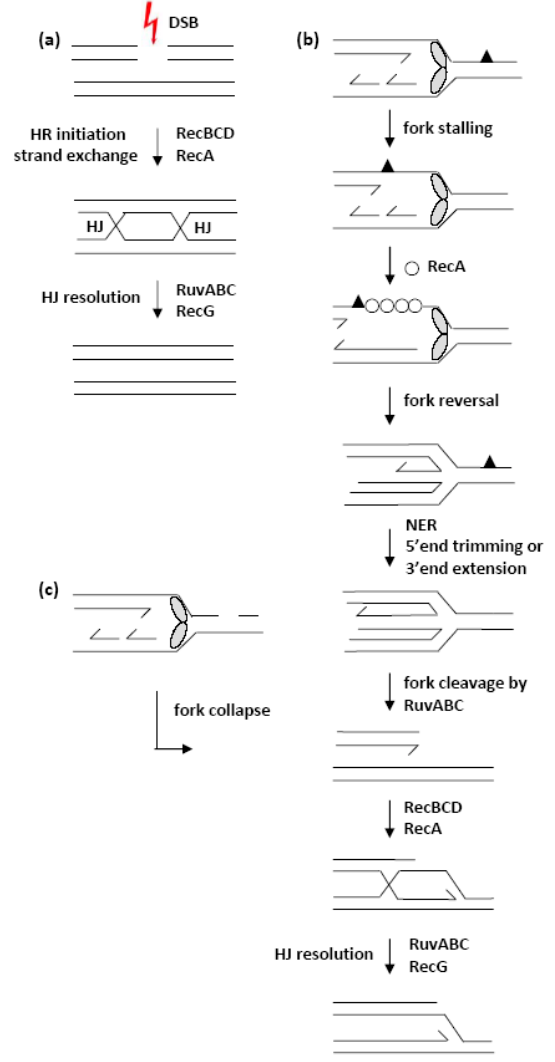
Figure 12. Models depicting the possible sources of DSBs and the corresponding repair pathways following the three different DNA-damaging treatments used in this work. ( a ) Classical DSB induced either by I- Sce I endonuclease or γ -irradiation has two dsDNA ends that are repaired by the RecBCD pathway of homologous recombination (HR). ( b ) In UV-irradiated cells, most DSBs are caused by the breakage of stalled replication forks. The drawing shows the progression of the replication fork on a DNA template damaged by UV radiation (grey ovals represent a replisome). An SSG occurs when the replication fork stops at a pyrimidine dimer (black triangle) on the leading strand template. The gap is then coated with RecA protein (white circles) in a process facilitated by the RecFOR complex [42] or an unknown factor (probably a replisome component) [21]. Homologous pairing catalysed by RecA leads to fork reversal, with concomitant replisome disassembly. Reversal of the replication fork allows NER enzymes to access the pyrimidine dimer and remove it. HJ formed by replication fork reversal is cleaved by the RuvABC resolvase thus creating a DSB. The RecBCD enzyme initiates the repair of DSB resulting in the restoration of the replication fork. ( c ) Minor sources of DSBs after UV and γ -irradiation. The replication fork runs into a single-stranded DNA interruption on the DNA template and collapses. In UV-irradiated cells, transient ssDNA breaks may arise due to ongoing NER. Alternatively, replication fork collapse can occur at unrepaired SSGs. In γ -irradiated cells, some DSBs may arise when replication fork encounters a site of ongoing base excision repair or an unsealed ssDNA break. Some ssDNA breaks could be widened by ssExos into SSGs that could also cause collapse of the replication forks